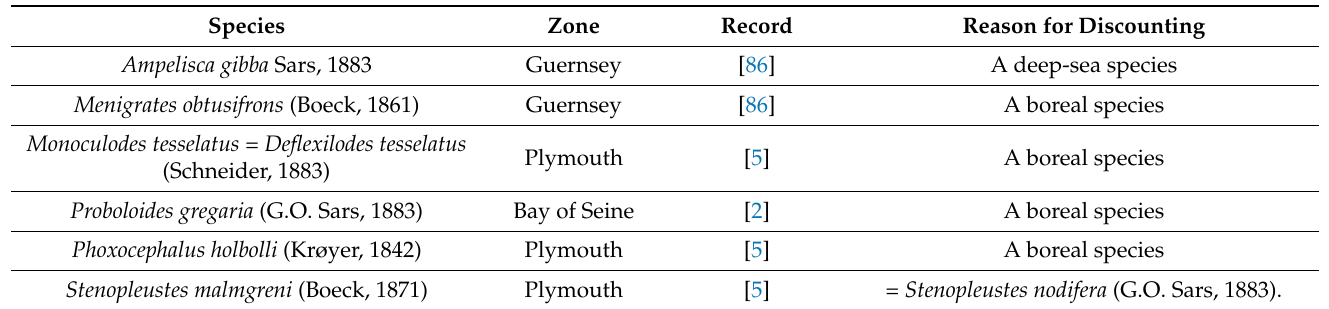
Table 3. Species reported as doubtful in the English Channel in